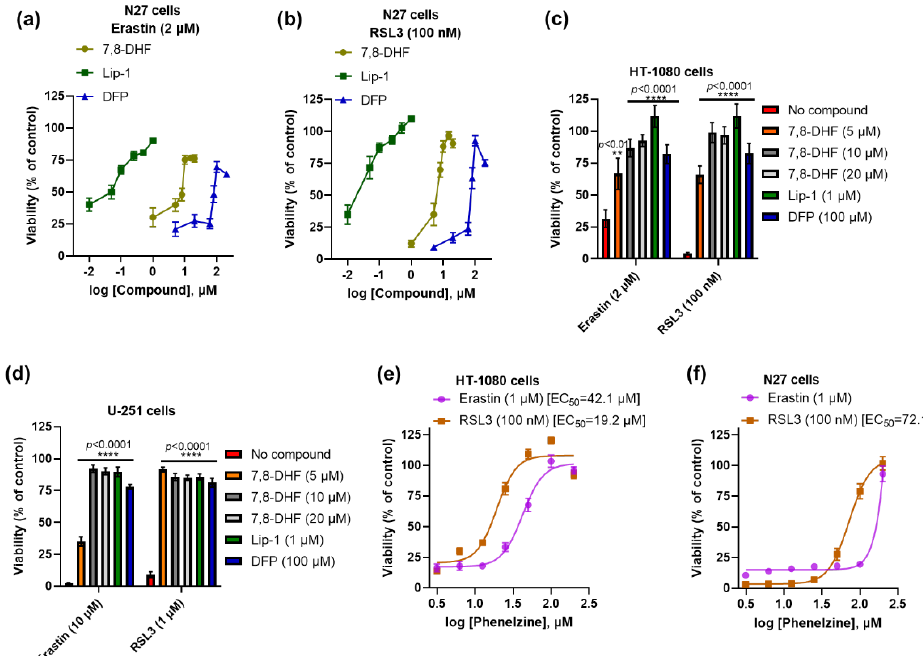
Figure 2. Both 7,8-DHF and phenelzine protect ferroptosis in several immortalised cell lines. Efficacy of 7,8-DHF, Lip-1, and DFP against erastin- and RSL3-induced ferroptosis in N27 cells ( a , b ). Like Lip-1 and DFP, 7,8-DHF significantly prevents ferroptosis in HT-1080 and U-251 cells ( c , d ). Efficacy of phenelzine against erastin- and RSL3-induced ferroptosis in HT-1080 and N27 cells ( e , f ). Cells were co-treated with ferroptosis inducers and tested compounds for 24 h. Cell viability was meas- ured by MTT assay. Data points signify mean percentage survival relative to untreated con- trols ± SEM, n = 12– 20 from 3 – 5 independent experiments. p values were calculated using the two- way ANOVA (Šídák's multiple comparisons test) , and the significant levels are noted as ** p < 0.01 and **** p < 0.0001 (vs. no compound). Moreover, 7,8-DHF and phenelzine significantly inhibited toxicity induced by the other ferroptosis activators FINO2 and tBH (Figure 3a,b). Since these immortalised cell lines did not express detectable TrkB receptors (Figure 1a), we hypothesised that ferrop- tosis inhibition might instead be due to intrinsic RTA properties of these compounds. In a cell-free 2, 2'-azino-bis (3-ethylbenzthiazoline-6-sulphonic acid (ABTS) assay, we con- firmed that both compounds have RTA activity (IC 50 of 7,8-DHF: 24.3 μM ; phenelzine: 40.9 μM), which was commensurate to the reference anti -ferroptotic RTA, Lip-1 (IC 50 =22.7 μM) (Figure 3c).